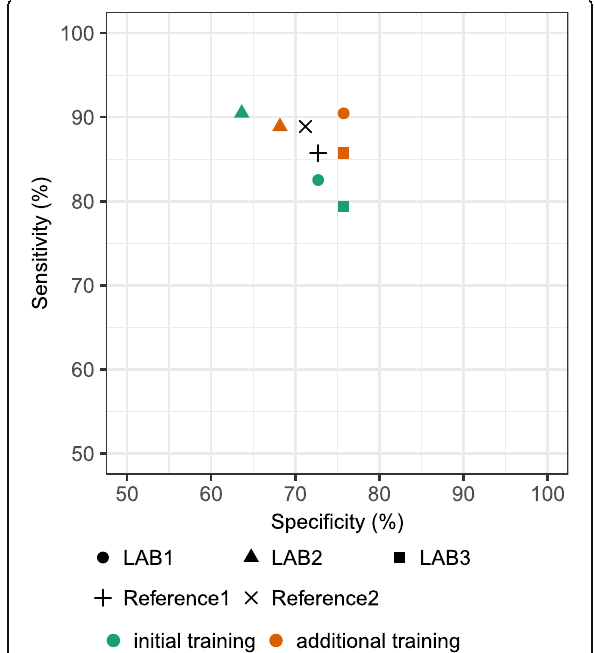
Fig. 1 Sensitivity and specificity of p16/Ki-67 DS for detecting CIN2+ LAB1 … laboratory1, LAB2 … laboratory2, LAB3 … laboratory3, Reference1 … consensus of 5 cytopathologists, Reference2